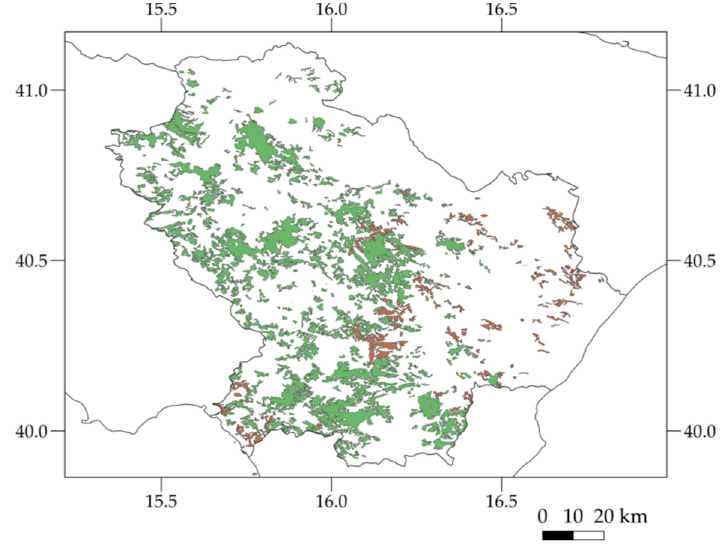
Figure 5. CLC—Level 4: 3.1.1.1 (Mediterranean evergreen oak forests, brown) and 3.1.1.2 (Deciduous oak forests, green) classes over the Basilicata region.